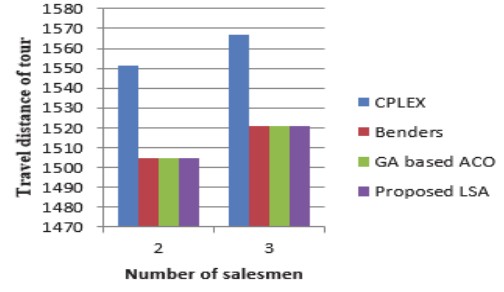
Fig. 7. Comparison of travel distance for ftv38 by considering two, and three salesmen